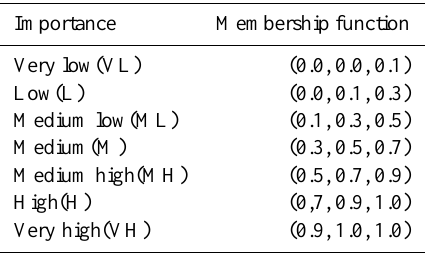
Figure 2. Fuzzy membership function with data distribution. Table 2. Linguistic variables and fuzzy membership function for the importance of